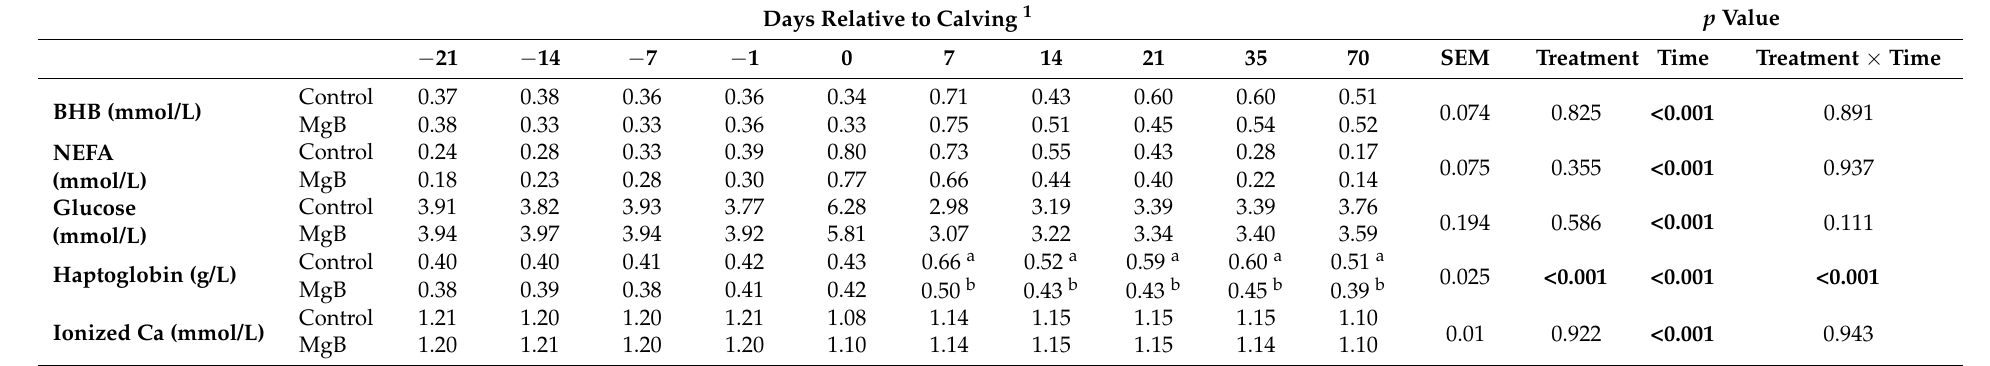
Table 3. Blood parameters of dairy cows with (MgB, n = 34) and without (Control, n = 31) prepartum magnesium butyrate supplementation. Days Relative to Calving